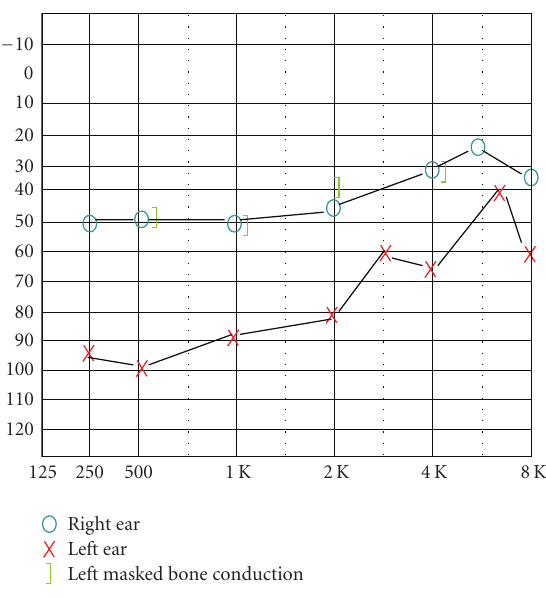
Figure 1: Audiogram prior to treatment.